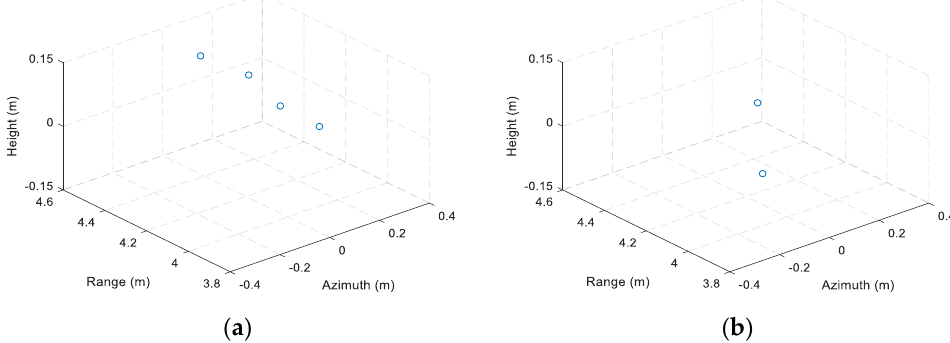
Figure 6. ISAR imaging results of two corner reflectors after signal calibration. ( a ) Antenna A; ( b ) Antenna B; ( c ) Antenna C.